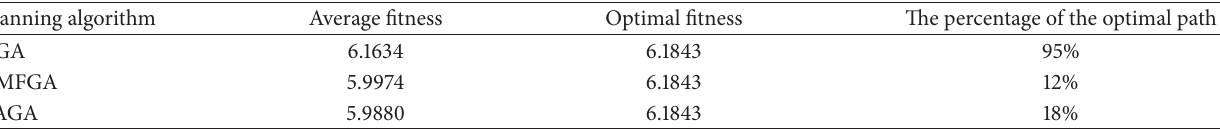
Table 3: Performance